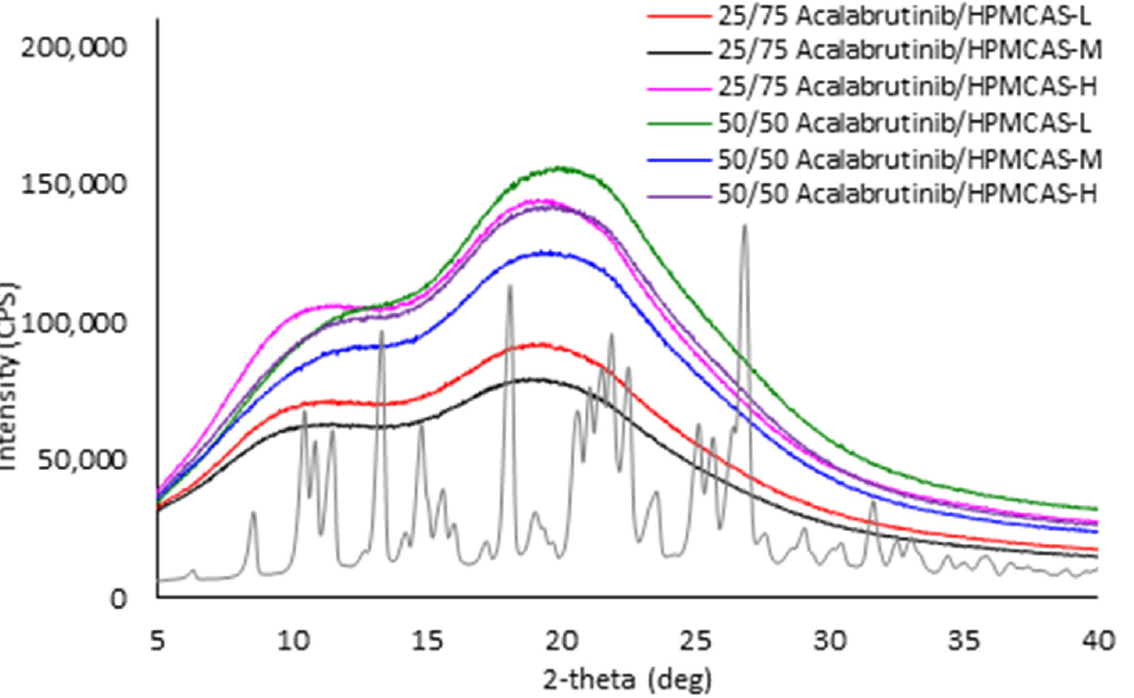
Figure A4. Powder X-ray diffractograms of manufactured acalabrutinib ASDs in comparison to acalabrutinib crystalline form I.